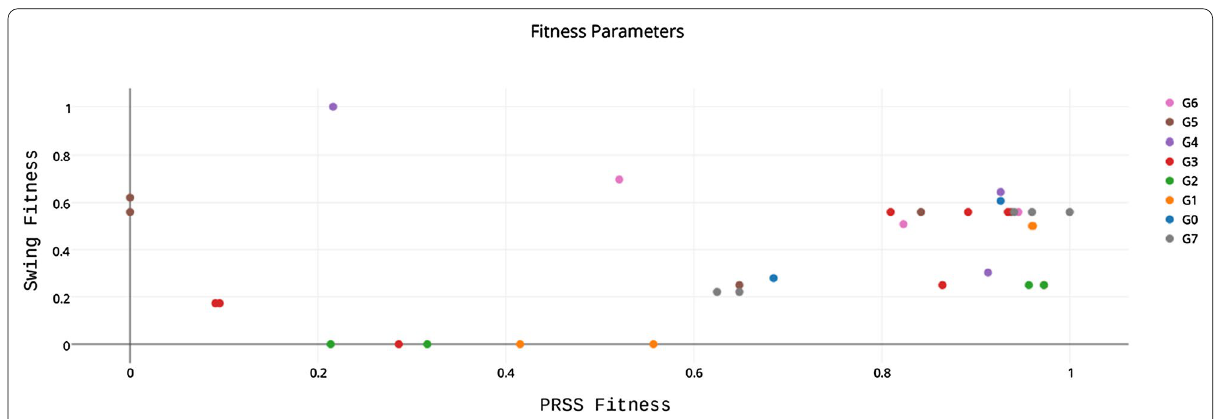
Fig. 26 The results of the swing